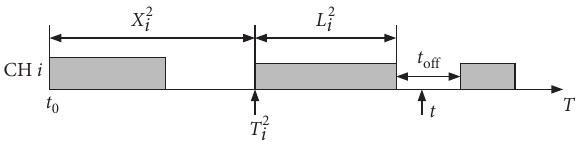
Figure 9: PU traffic activity on channel i